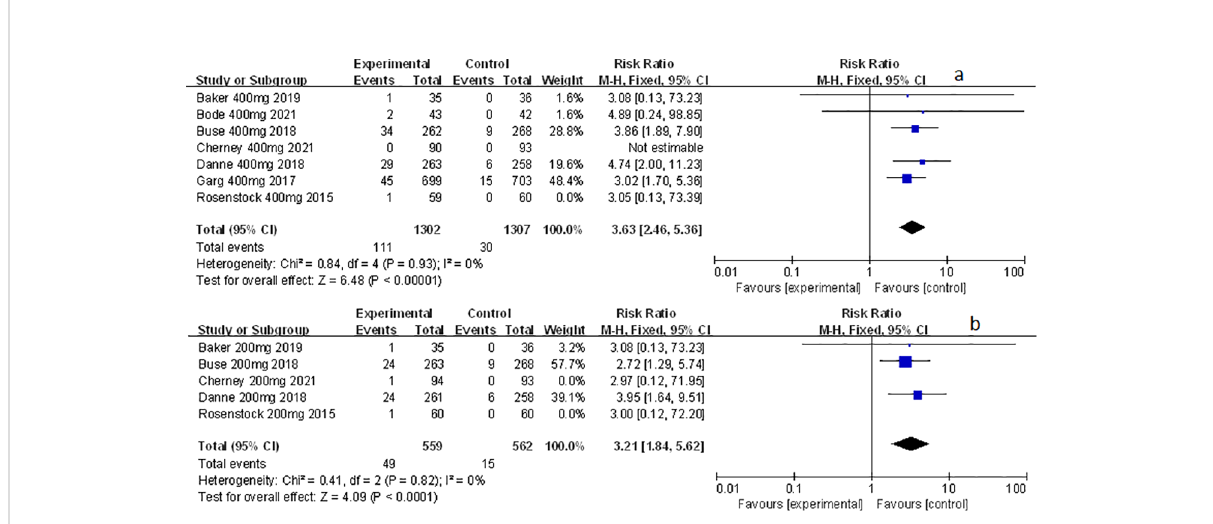
FIGURE 2 Forest plot of genital mycotic infection in the subgroup of sotagli fl ozin 400mg and 200mg versus the control group in T1D. (A) The adverse events of genital mycotic infection in the subgroup of sotagli fl ozin 400mg versus placebo. (B) The adverse events of genital mycotic infection in the subgroup of sotagli fl ozin 200mg versus